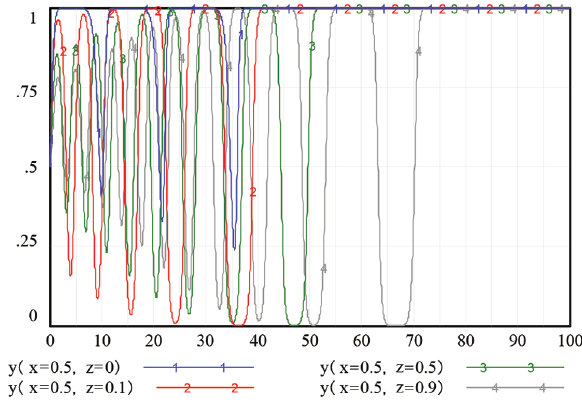
Figure 11. Game results when z